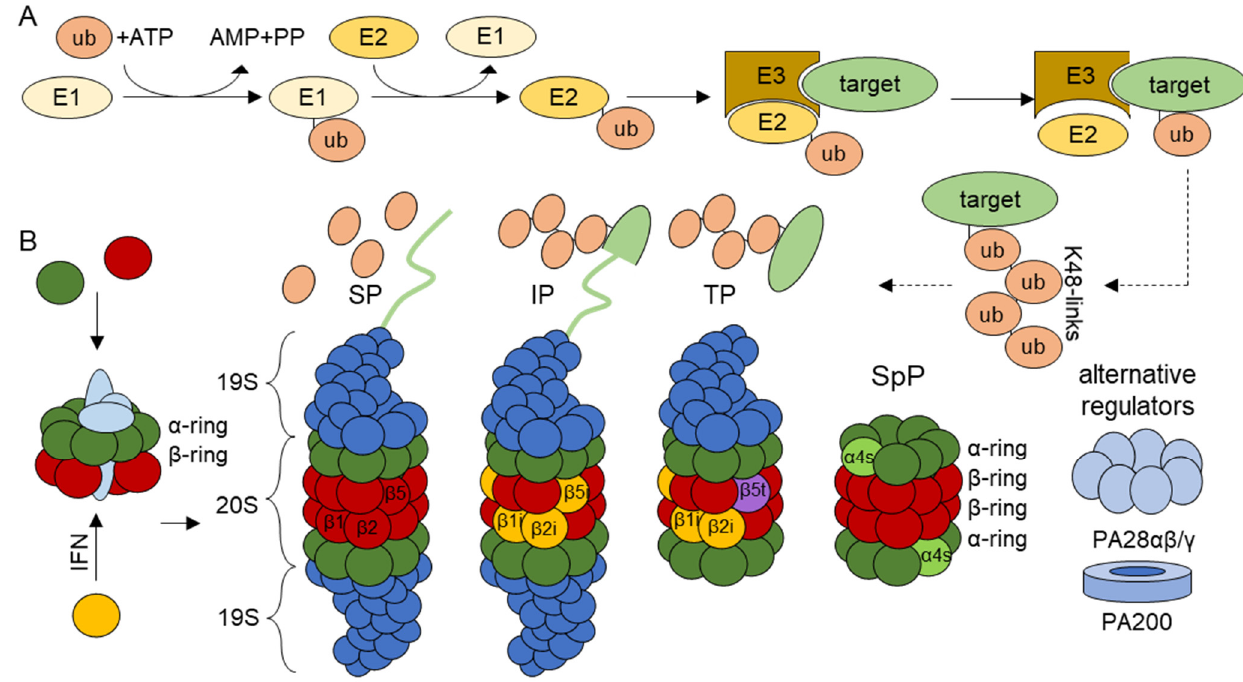
Figure 1. Schematic representation of ubiquitylation and proteasomal protein degradation. ( A ) Proteins destined for proteasomal degradation are conjugated with ubiquitin in a three-step cascade. First, E1-ubiquitin-activating enzymes bind to ubiquitin in an ATP-dependent reaction. This ubiquitin is transferred onto a E2-ubiquitin conjugating-enzyme. The E3-ubiquitin-ligase binds to both ubiquitin-conjugated E2-enzymes and target substrates which thereby undergo modification with ubiquitin. Ubiquitylated proteins can be polyubiquitylated. Depicted is a K48 linked polyubiquitylation, where ubiquitin is consecutively attached to the lysine 48 of the already bound ubiquitin. ( B ) The 20S proteasome core particle is made up of α - and β -subunits. The assembly to αββα asymmetric heptameric rings is guided by assembly chaperones. Each 20S core particle consists of two outer α -rings and two inner β -rings. In standard proteasomes (SPs), the catalytically active subunits are β 1, β 2 and β 5. In immunoproteasomes (IPs), these subunits are replaced by the inducible subunits LMP2 ( β 1i), MECL1 ( β 2i) and LMP7 ( β 5i). IPs are preferentially incorporated to newly synthetized proteasomes in response to IFN, as indicated. Additional isotypes include the thymoproteasome (TP) which contains a unique β 5t protease subunit and the spermatoproteasome (SpP) that incorporates a specific structural α 4s subunit. The active sites of the catalytic subunits face the inside of the 20S barrel shape. Proteasomes can bind to different regulators on one or both sides. The 19S regulator has receptors for poly-ubiquitylated proteins and helps to unfold the proteins, remove ubiquitin from substrates and translocate them into the 20S for degradation. The regulators can attach to different isoforms on either or both sides. Additionally, combinations of the 19S regulator and PA28 αβ / γ or PA200 regulators exist.